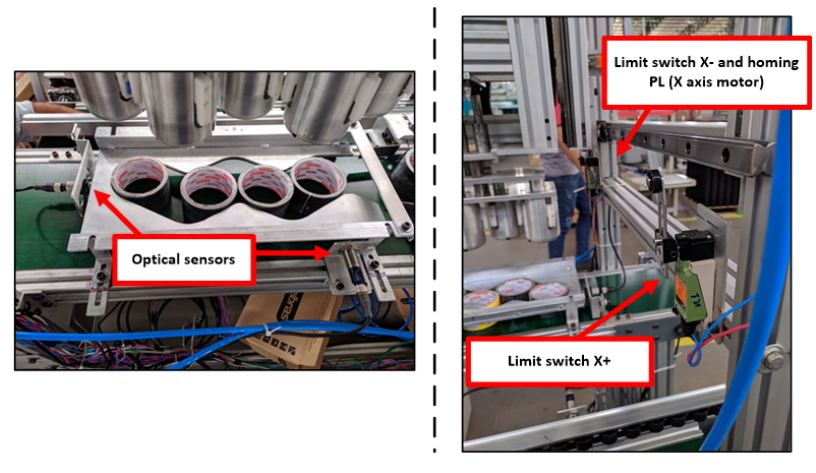
Figure 8. Installation of optical sensors and limit switches.